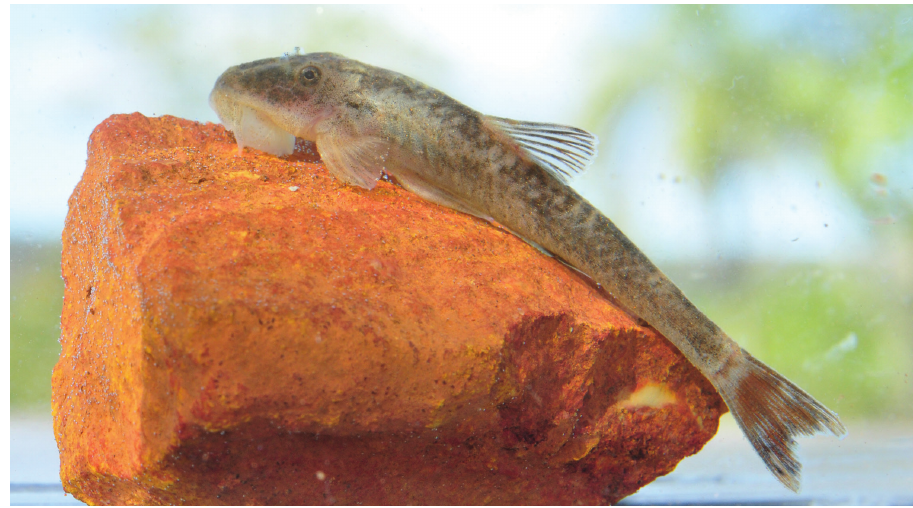
Figure 3. Rhinolekos capetinga , live specimen, MZUSP 116102, holotype, male, 37.5 mm SL, rio Tocantins basin, Goiás State, Brazil. Photo: FF